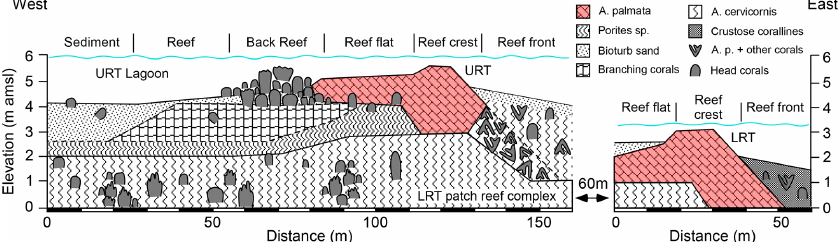
Figure 10. Schematic cross section through the LIG reef tracts located at Xcaret, Mexico, as composed by Blanchon et al. (2009). LRT is lower reef tract, URT is upper reef tract, and A.p. is Acropora palmata . Redrawn with permission from Blanchon et al.